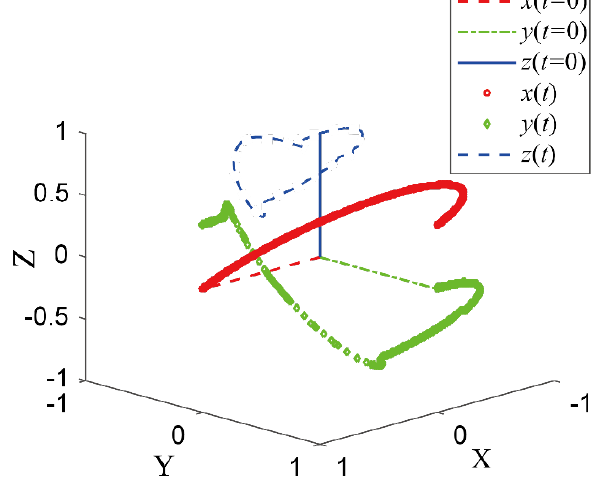
Figure 15. The 3D representation of the time-optimal reorientation for Case